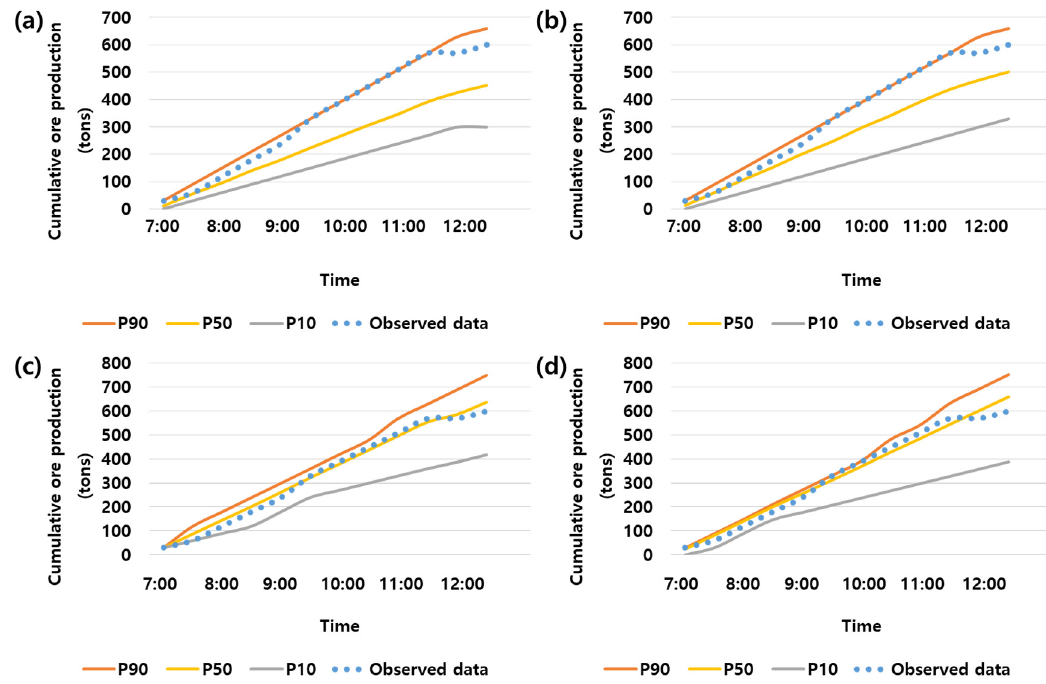
Figure 8. Comparison of the simulation and haulage operations results (observed) obtained on 16 October 2018 for ( a ) uniform distribution, ( b ) triangular distribution, ( c ) normal distribution, and ( d ) observed probability distribution.